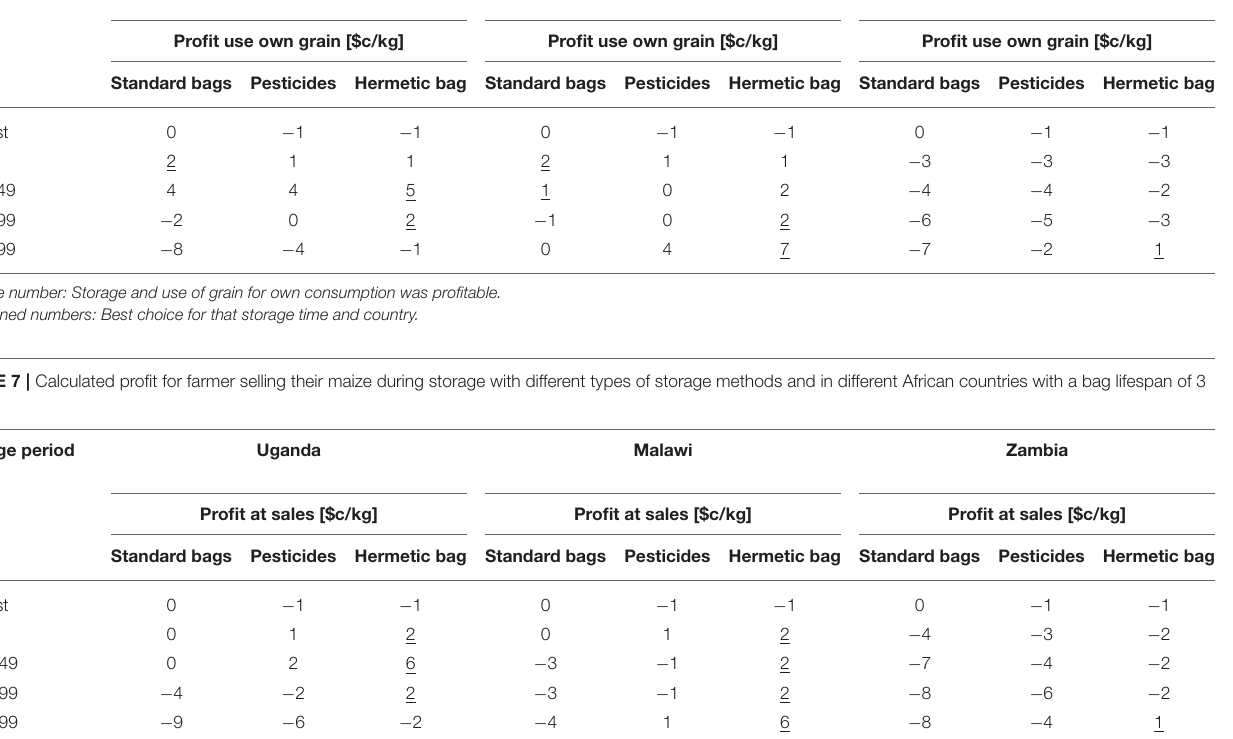
TABLE 6 | Calculated savings for farmers consuming their own maize instead of purchasing maize from local markets during storage with different types of storage methods and in different African countries with a bag lifespan of 3 years. Storage period Uganda (days)